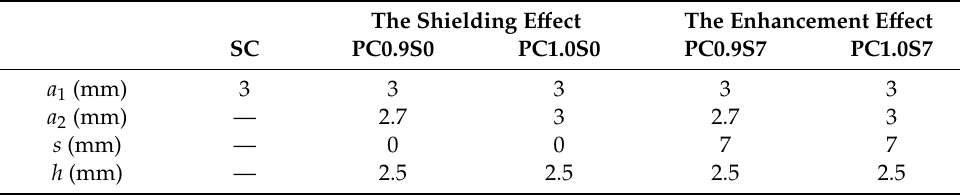
Table 2. Positions and sizes of the notch cracks in the